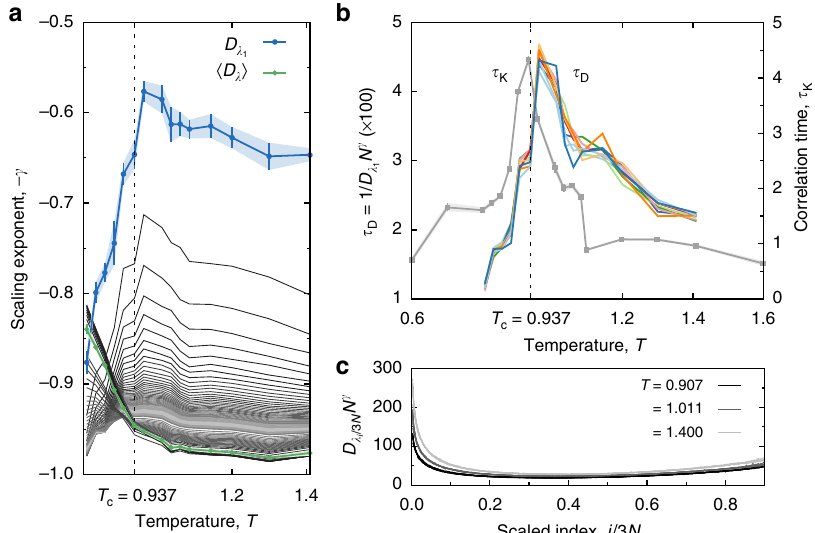
Fig. 4 Maxima in dynamical timescales of Lyapunov exponent fl uctuations. Weak self-averaging for the largest positive exponents indicates statistical dependence of spatial domains near the critical point. a The (negative) wandering exponent as a function of temperature T at ρ c for the diffusion coef fi cient of the fi rst fi nite-time Lyapunov exponent. Also shown are the − γ for average diffusion coef fi cients where averaging includes an increasing number of (cid:4) 1 = D N γ , and peak in the correlation time Lyapunov exponents in the spectrum. b Peak in the dynamical timescale for Lyapunov exponent fl uctuations, τ λ 1 D of kinetic energy per particle, τ K . c Data collapse for the scaled diffusion coef fi cient of fi nite-time Lyapunov exponent spectra as a function of the scaled Þ . All data are at the critical density for the three-dimensional Lennard – Jones fl uid. spectral indices: the functional form is the scaling function ~ D ð T ; ρ ¼ ρ c Error bars indicate the standard deviation (1 σ